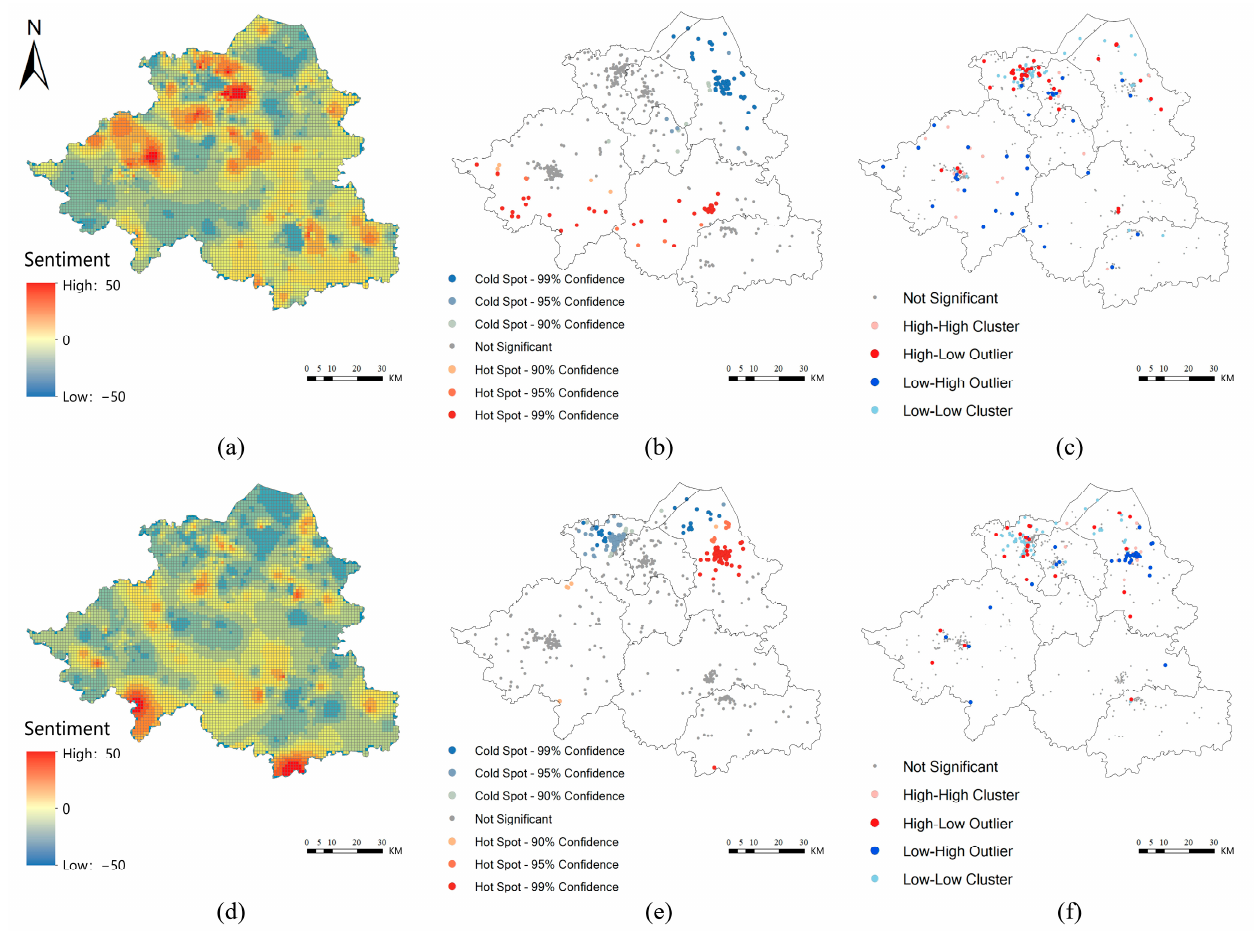
Figure 7. Analysis of public sentiment, cold/hot spots and local Moran’s I before and amidst COVID-19: ( a ) Prepandemic public sentiment map; ( b ) Prepandemic cold-hot spots; ( c ) Prepandemic local Moran’s I; ( d ) Postoutbreak public sentiment map; ( e ) Postoutbreak cold/hot spot analysis; ( f ) Postoutbreak local Moran’s